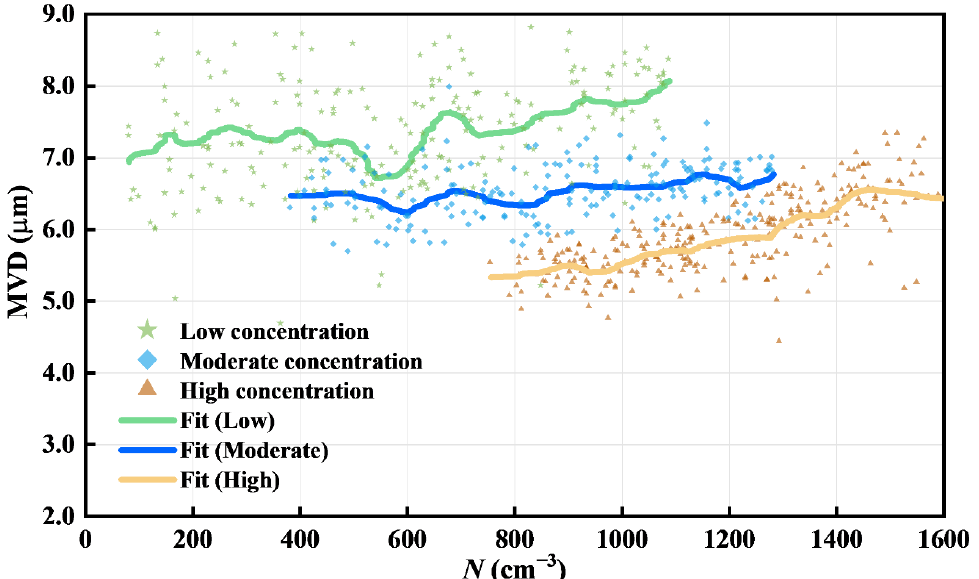
Figure 14. Correlation analysis between N and MVD at three different aerosol concentration levels: high, moderate, and low.